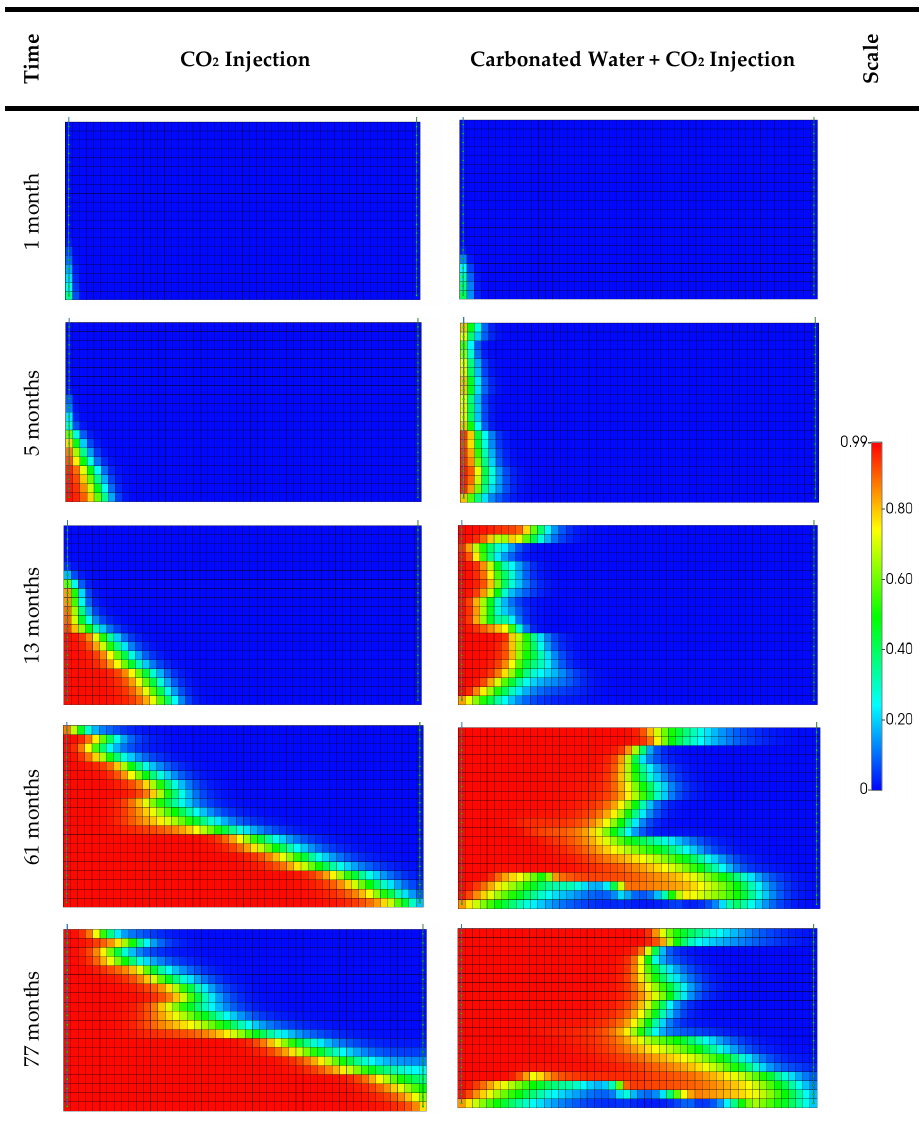
Figure 10. Overall CO 2 mole fraction at different times for CO 2 injection only (left) and carbonated water combined with CO 2 injection (right). The time is given in months since injection began.